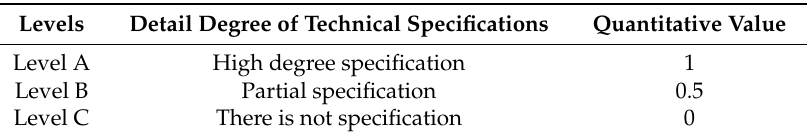
Table 10. Description of the level quantification used to analyze the MCSs presented in the reviewed